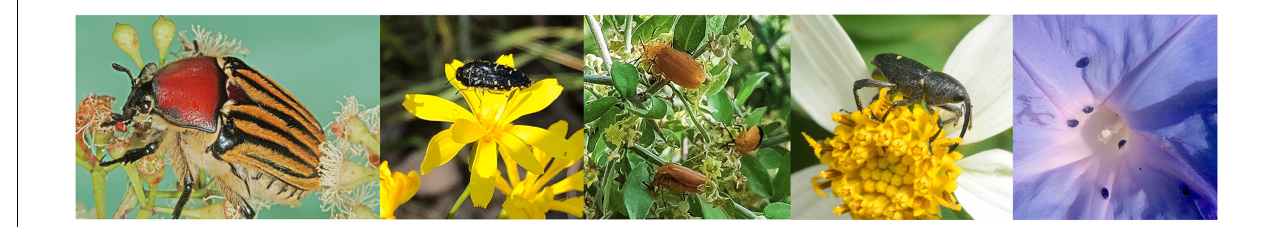
FIGURE 1 | Flower-visiting beetle families included in this study. From left to right: Cetoniinae ( Trichaulax philipsii) , Buprestidae ( Acmaeodera sp.), Lycidae ( Lycus sp.), Curculionidae and Nitidulidae ( Aethina concolor ). Images by: Chris Moeseneder, GSP, Russ Anderson, Steven Marshall,